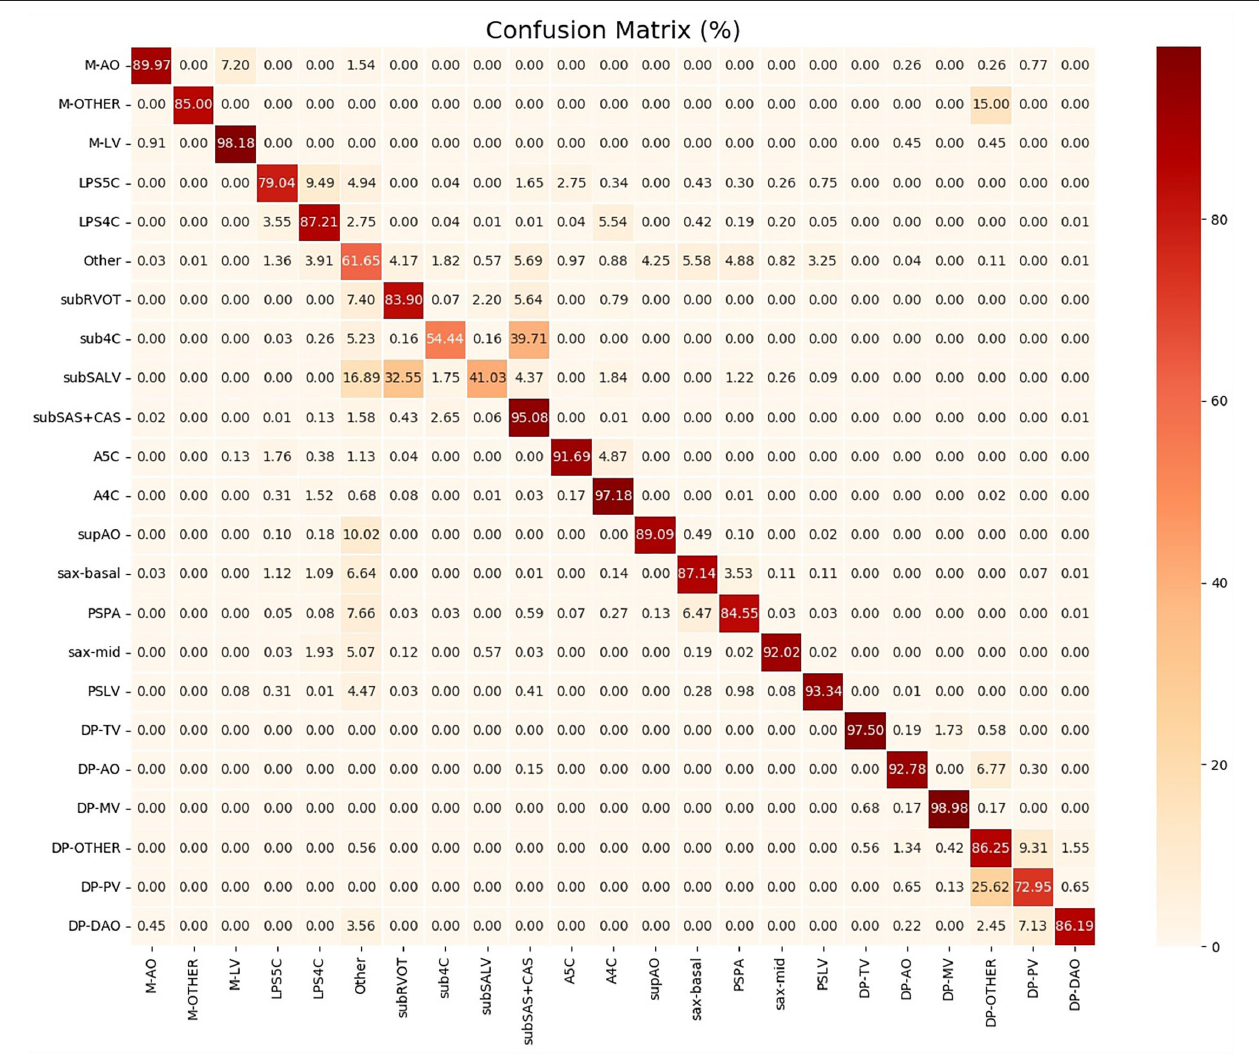
FIGURE 5 | The confusion matrix between different echocardiographic views.